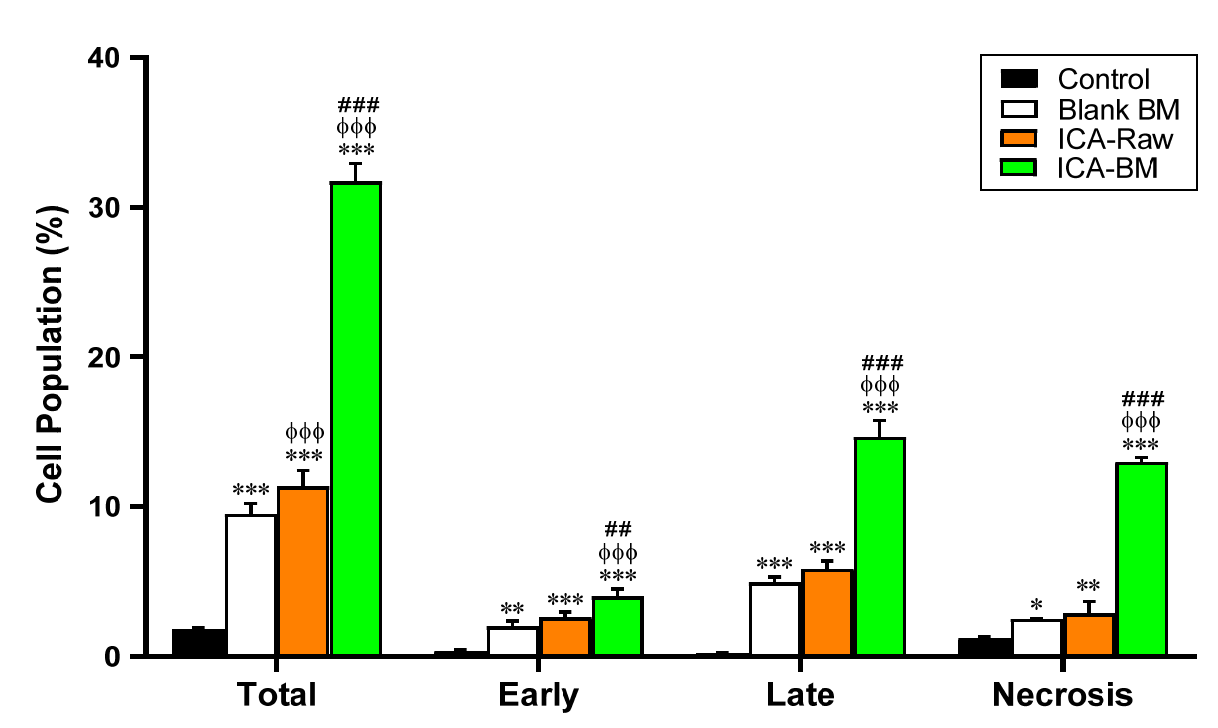
Figure 6. Effect of Blank BM, ICA-Raw, and ICA-BM on the percentage of apoptotic or necrotic PANC1 cells. Data are the mean of 4 independent experiments ± SD. * Significantly different vs. Control ( p < 0.05); ** Significantly different vs. Control ( p < 0.01); *** Significantly different vs. Control ( p < 0.001); φφφ Significantly different vs. Blank BM ( p < 0.001); ## Significantly different vs. ICA-Raw ( p < 0.01); ### Significantly different vs. ICA-Raw ( p < 0.001).